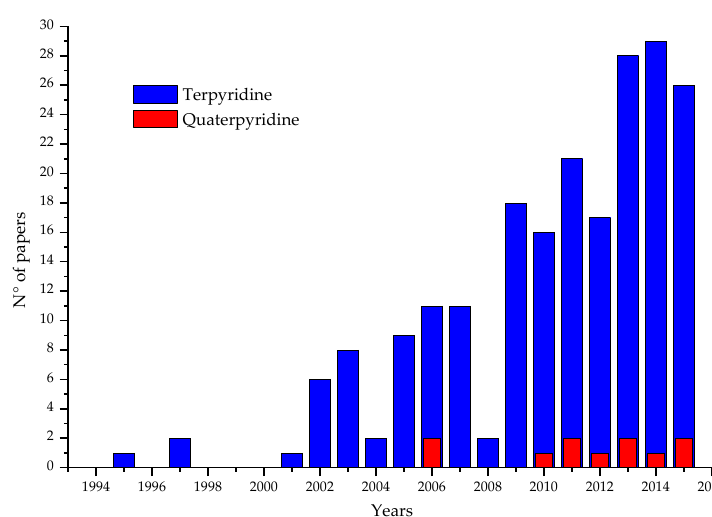
Figure 1. Publications concerning the use of terpyridines (blue) and quaterpyridines (red) in DSCs. Source: SciFinder (January 2016) [15].